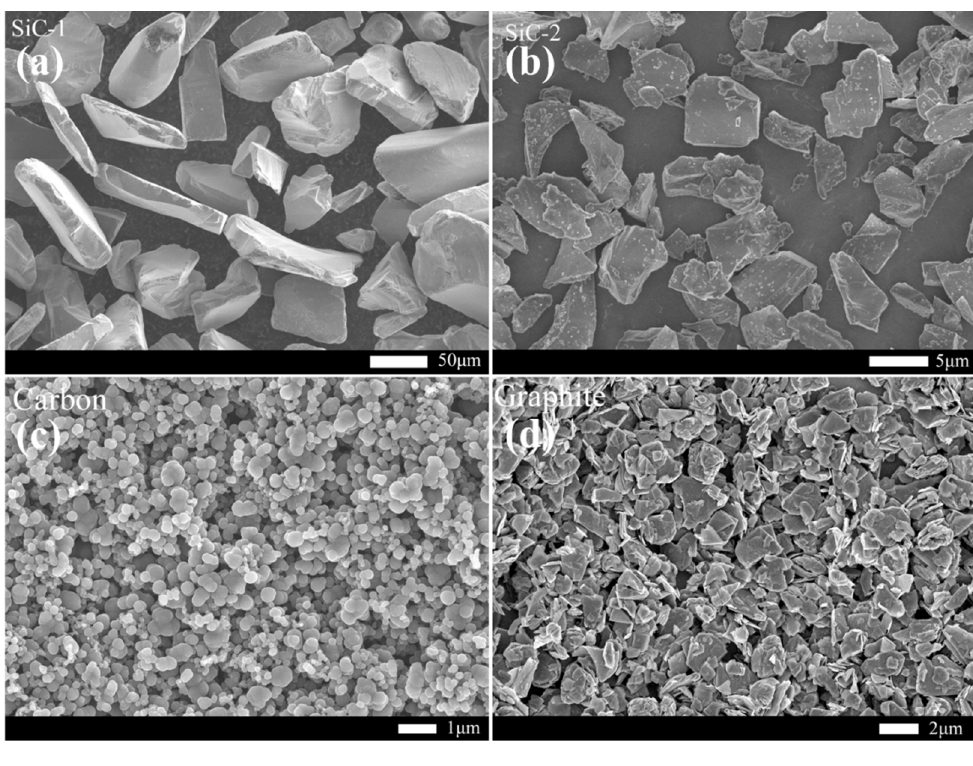
Figure 2. SEM micrographs of raw material powders.